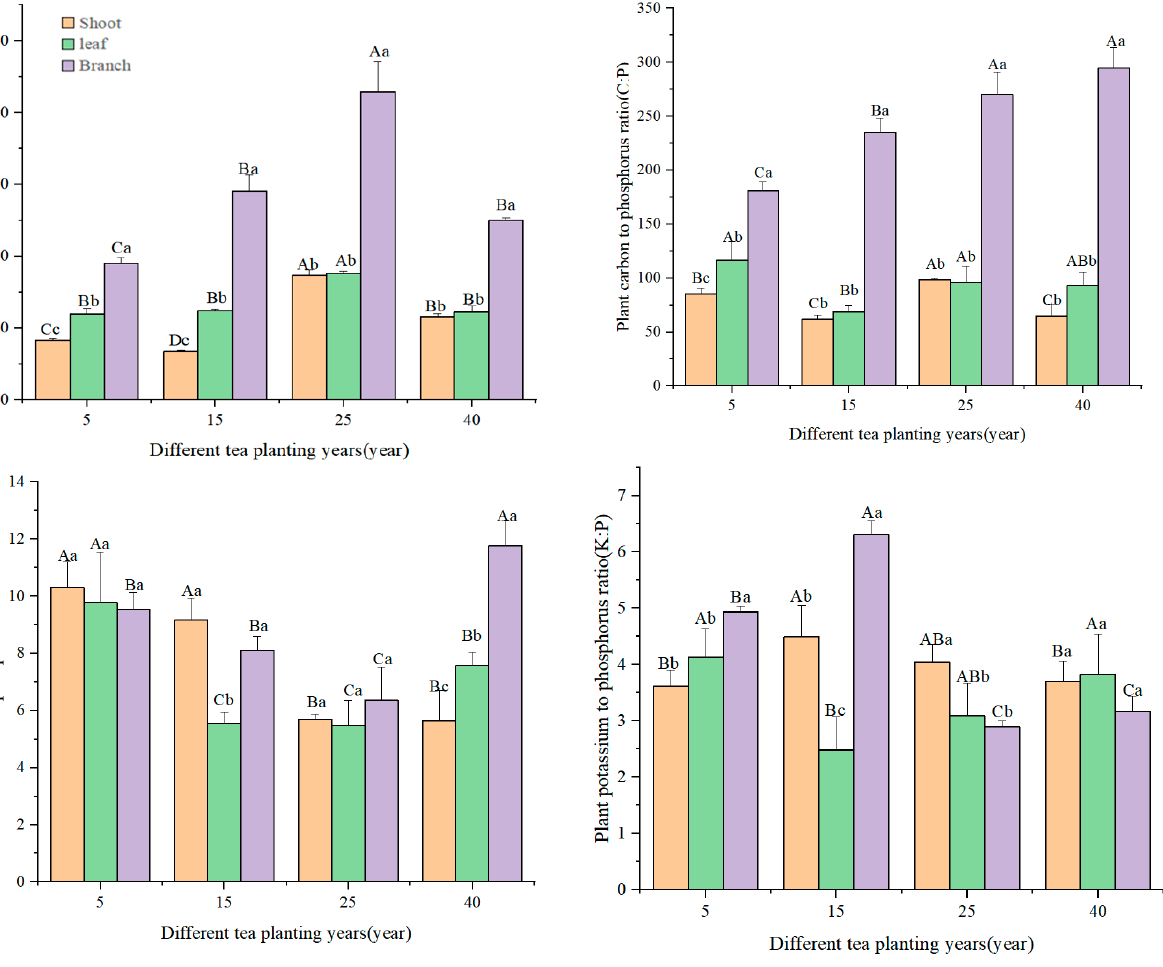
Figure 4. Stoichiometric ratio of plant nutrients under di ff erent planting years. Di ff erent capital letters indicate signi fi cant di ff erences between planting years, di ff erent lowercase le tt ers indicate signi fi cant di ff erences between di ff erent parts ( p < 0.05).